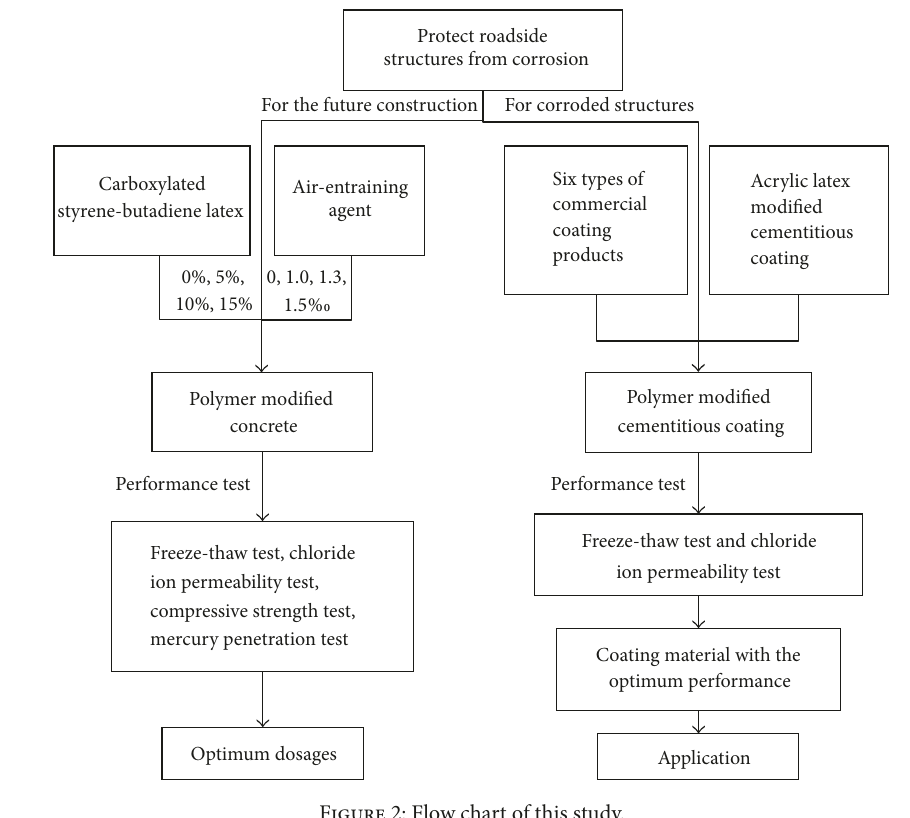
Figure 2: Flow chart of this study. Table 1: Properties of the air entraining agent.